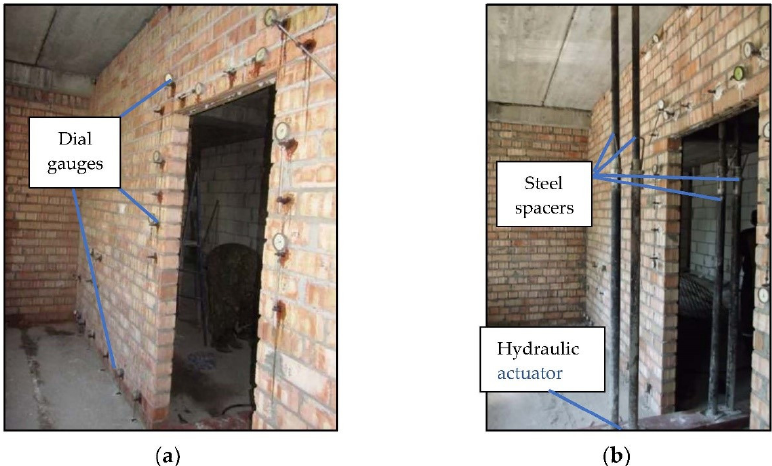
Figure 8. View of the partition walls under study ( a ) with fitted measuring tools and ( b ) steel spacers for floor loading.